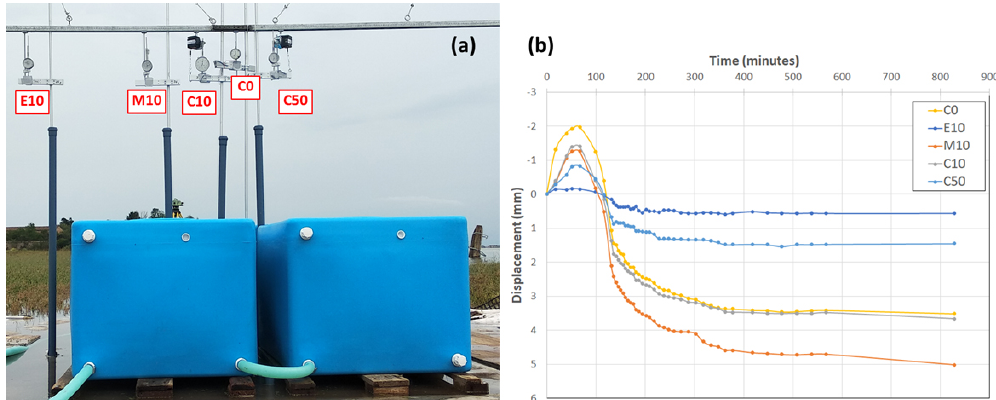
Figure 5. (a) Displacement transducers (C0: central position at the land surface; C10: central position at 10cm depth; M10: median position at 10cm depth; E10: external position at 10cm depth; C50: central position at 50cm depth). (b) Displacements recorded during phase 2 unloading and phase 3 loading cycles; negative values mean uplift, positive